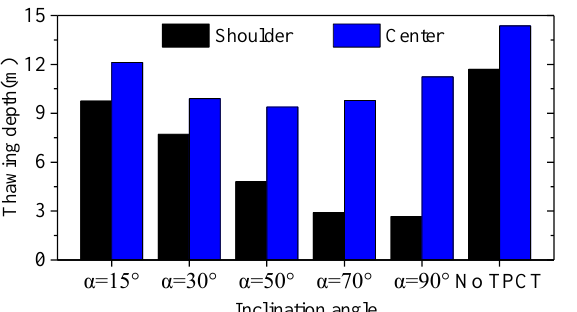
Figure 9. The thawing depth at the subgrade shoulder and center on 1 October after 30 years of construction.